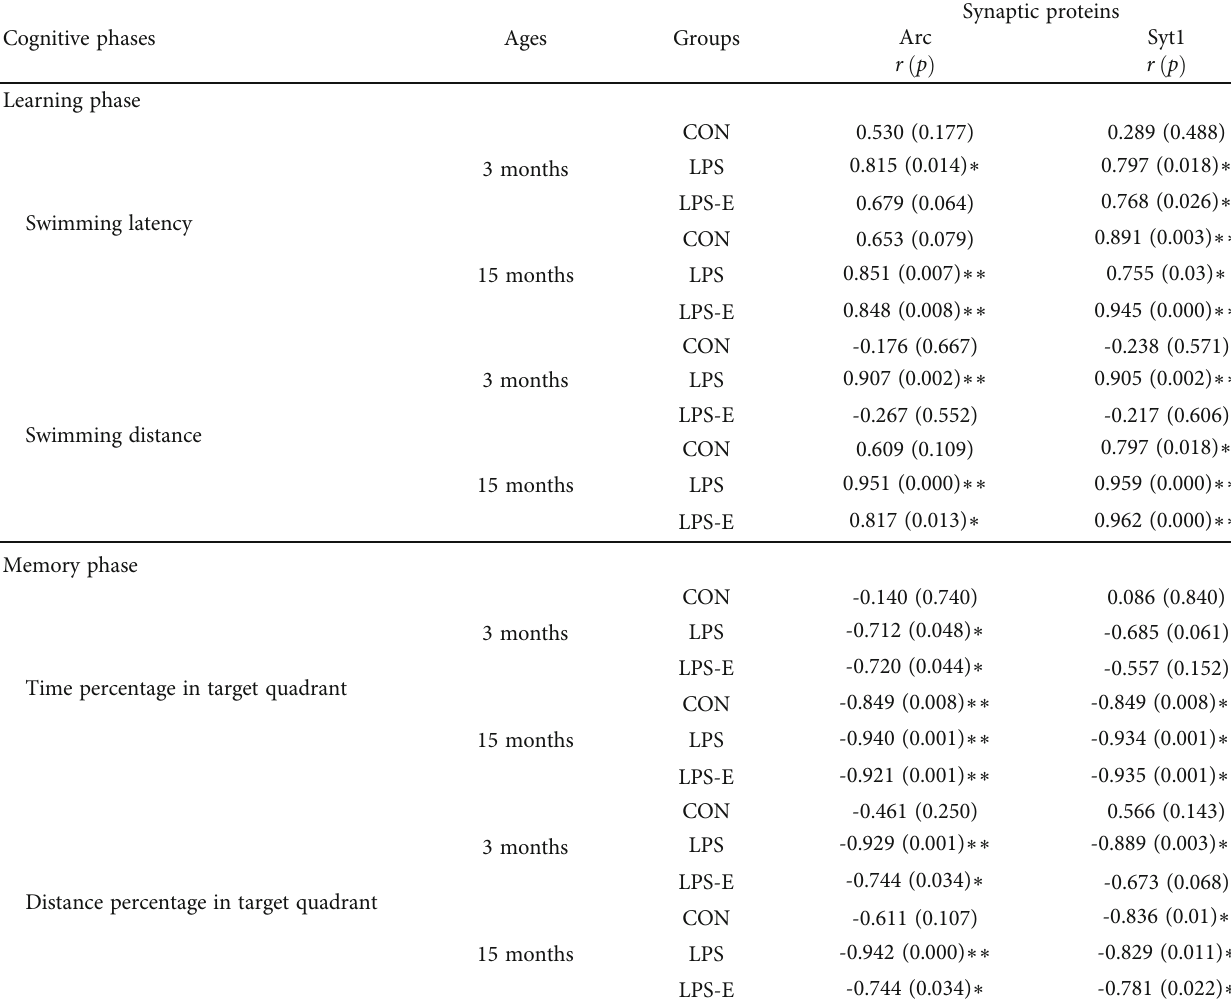
Table 1: Correlations between groups with regard to performance in the MWM and hippocampal synaptic proteins. Cognitive